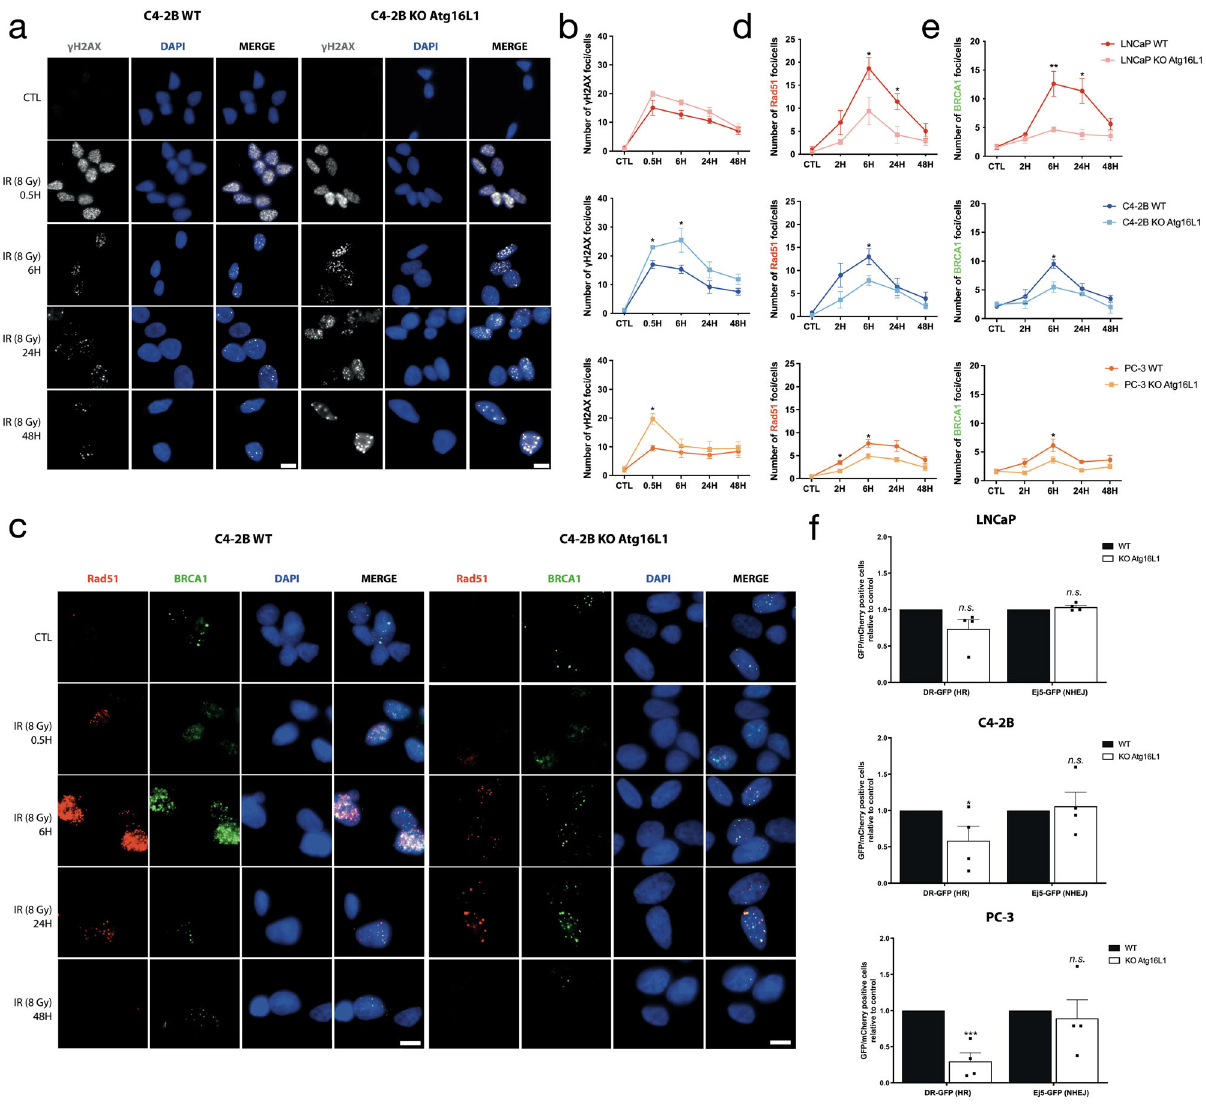
Fig. 4 Autophagy-depleted PC cells repair DNA breaks using NHEJ. a Representative images (C4-2B WT and KO Atg16L1 ) of the number of γ -H2AX foci per nucleus in WT and KO cells of C4-2B after 8 Gy irradiation. b Quanti fi cation of γ -H2AX foci per cells. c Representative images (C4-2B WT and KO Atg16L1 ) of the number of Rad51 and BRCA1 foci per nucleus in WT and KO cells of C4-2B after 8 Gy irradiation. d, e Quanti fi cation of Rad51 and BRCA1 foci per cell. f Analysis of HR (DR-GFP) and NHEJ (Ej5-GFP) activity in WT and KO cell lines by fl ow cytometry. The mean ± SEM of three ( b ) or four ( d , e ) independent experiments is shown. Data were analyzed using the two-tail Student t -test. n.s. = nonsigni fi cant. * p < 0.05,** p < 0.01 and ***p < 0.001. Scale bar 10 µ